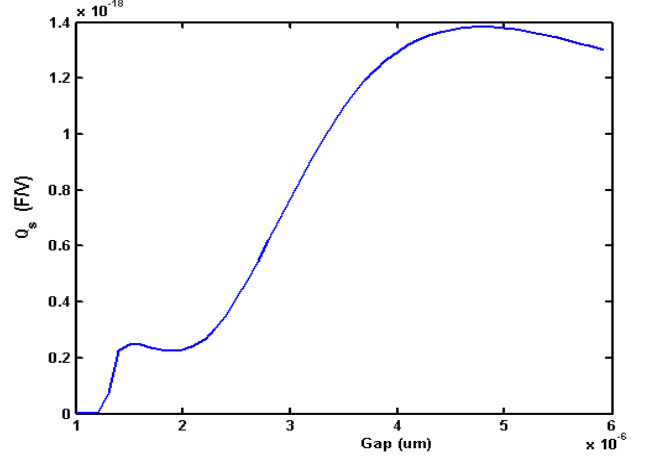
Figure 19. Effect of gap on sensor sensitivity for 200 μ m × 200 μ m × 3 μ m plate, with V = 10 V, P = 101,000 Pa, k = 51.65 N/m, Δ m / m o a flex